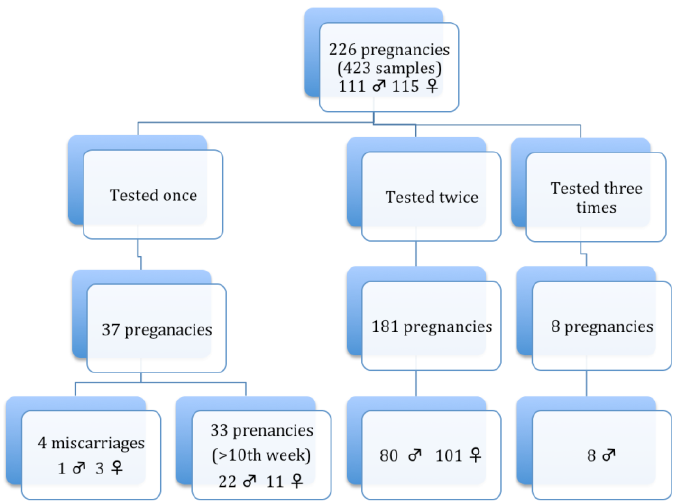
Figure 1. Schematic representation of the 226 pregnancies studied over 5 years.